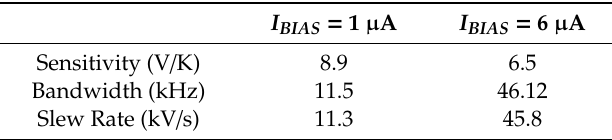
Figure 10. ( a ) Transfer curves of the core sensor for different I BIAS currents and ( b ) sensitivity Figure10. ( a )Transfercurvesofthecoresensorfordi ff erent I BIAS currentsand( b )sensitivitydependence dependence on I BIAS . on I BIAS . Table 2. Temperature Sensor Table 2. Temperature Sensor Performance.